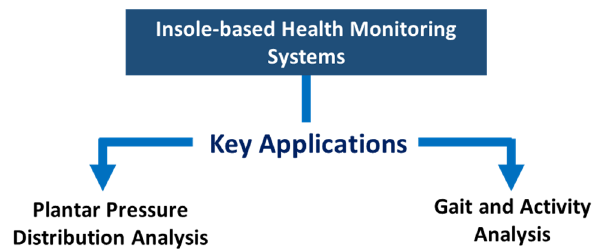
Figure 3. Insole-based systems typically have one of two focuses: obtaining detailed PPD or gait event/characteristic event/characteristic analysis.